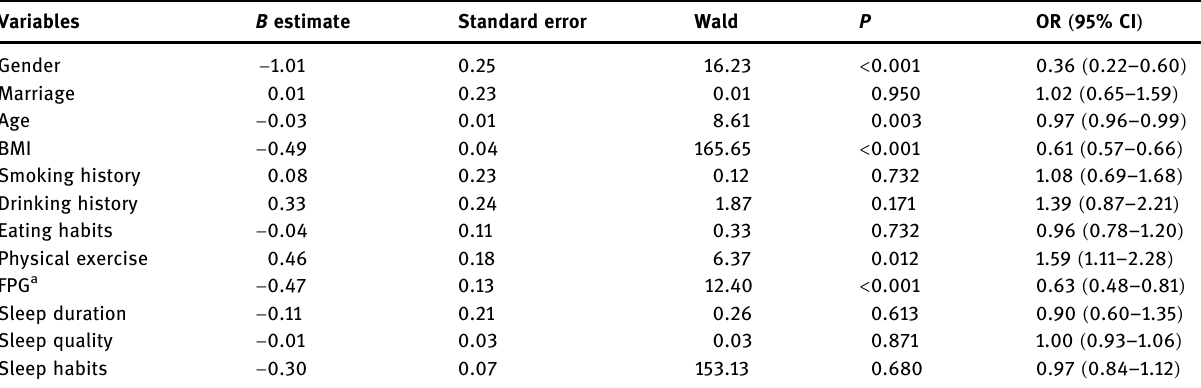
Table 3: Multivariate logistic regression analysis for NAFLD